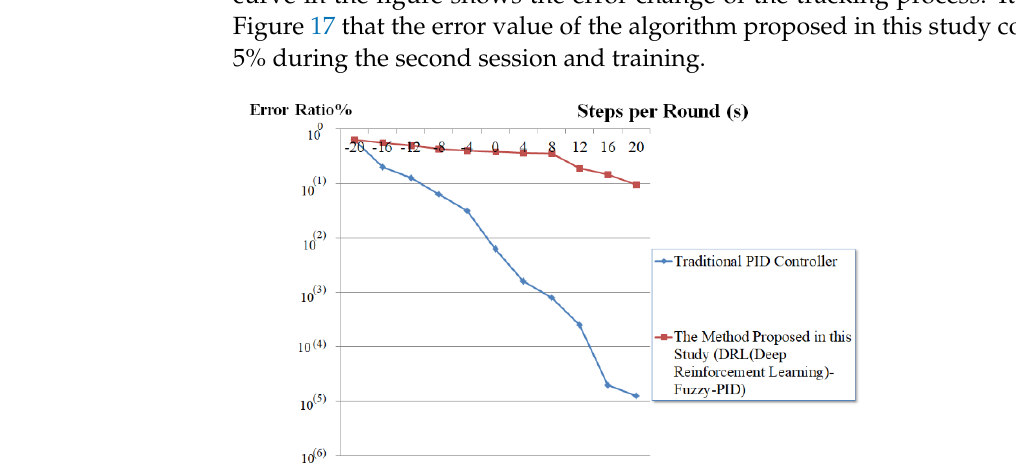
Figure 17. Analysis of tracking control error of deep reinforcement learning controller .